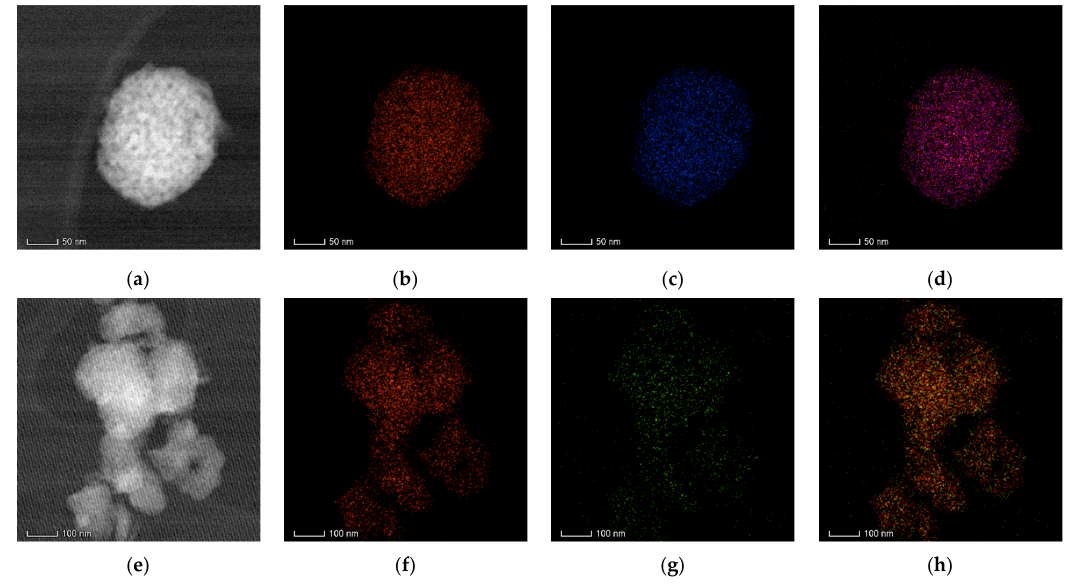
Figure 10. STEM image of TiO 2 − Cu 2.0% MW ( a ) and TiO 2 − Zn 2.0% MW ( e ) samples, EDX map of Ti in TiO 2 − Cu 2.0% MW ( b ) and TiO 2 − Zn 2.0% MW ( f ), Cu in TiO 2 − Cu 2.0% MW ( c ), Zn in TiO 2 − Zn 2.0% MW ( g ), Ti + Cu in TiO 2 − Cu 2.0% MW ( d ), and Ti + Zn in TiO 2 − Zn 2.0% MW ( h